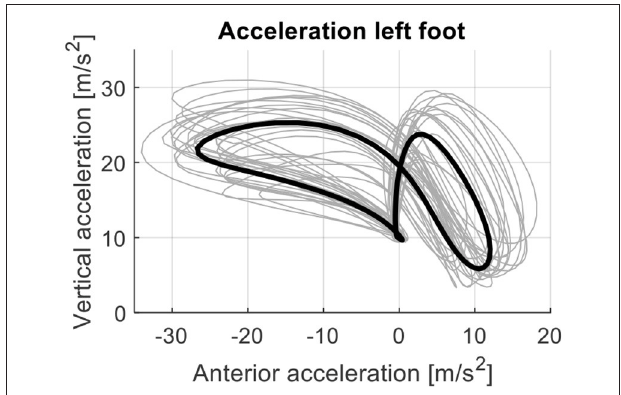
FIGURE 2 | The reference attractor (black line; mean of individual attractors) and individual attractors of all healthy persons ( N = 24; gray lines) for the left foot. Individual attractors were based on acceleration data of the foot during the first minute of the 6MWT. Differences in patterns between subjects remained after correcting for walking